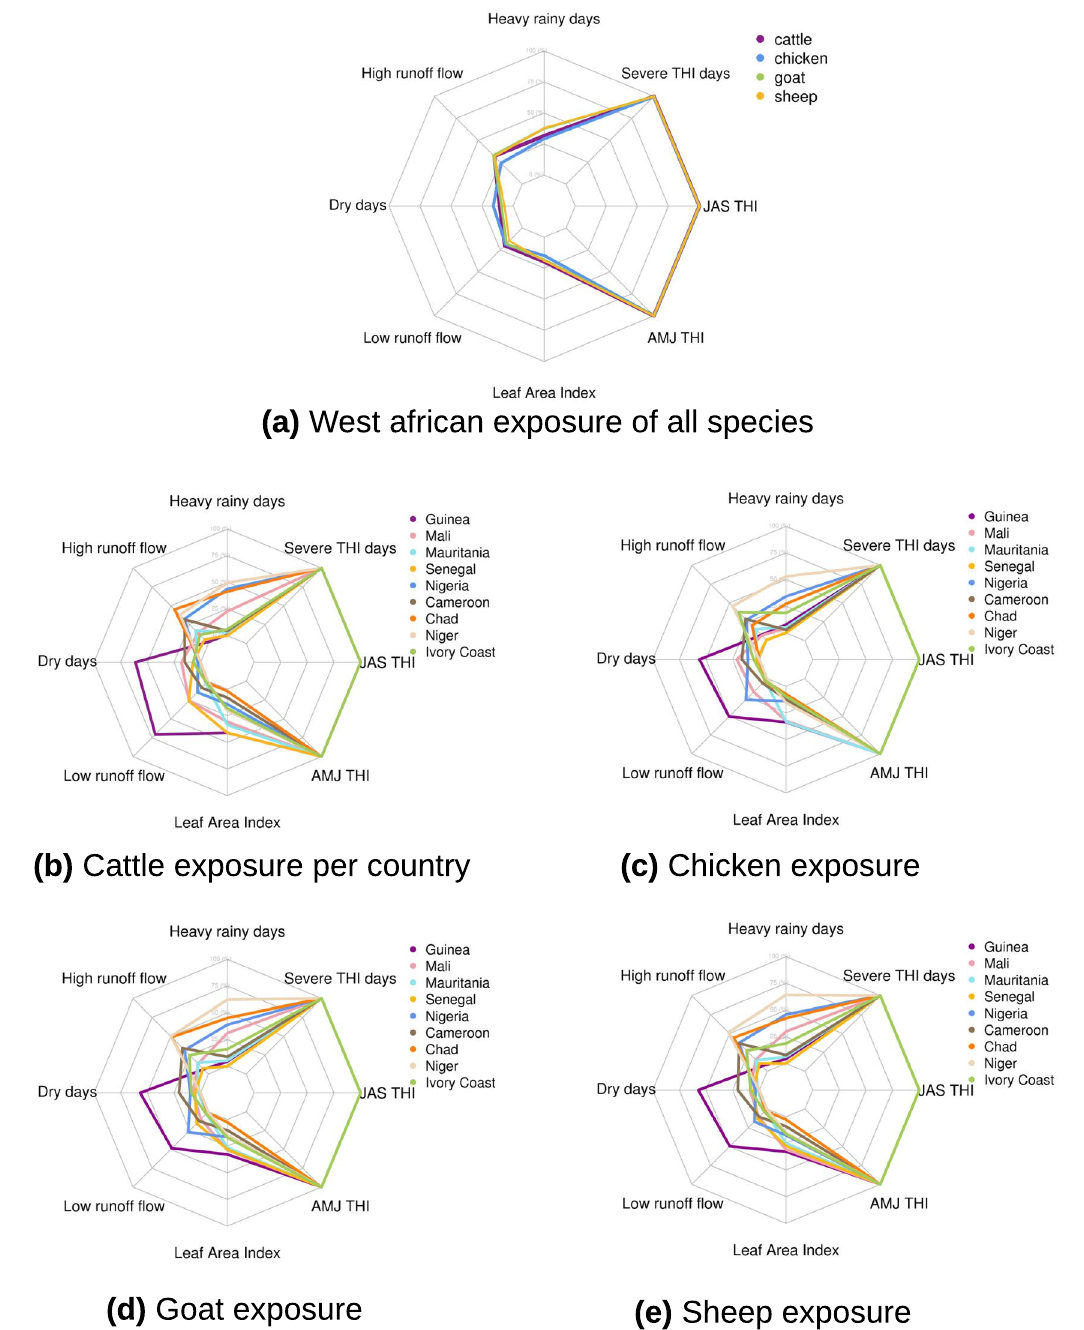
Figure 3. Radarcharts of exposed livestock species to each of the eight selected climate stressors for ( a ) all Western Africa, and ( b – e ) per country (in % of total number of animals per species). Exposure is calculated for each indicator as the sum of all grid points where future projected change is at least equal to the corresponding historical standard-deviation as described in the Methods